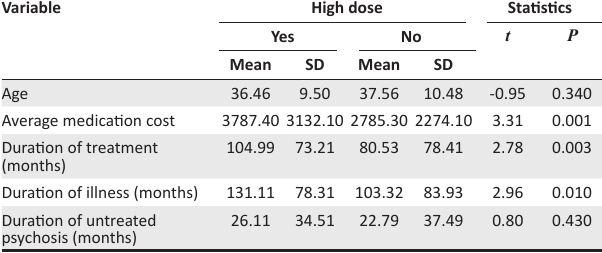
TABLE 3: Comparison of sociodemographic characteristics (continuous variables) of participants and high dose prescribing.